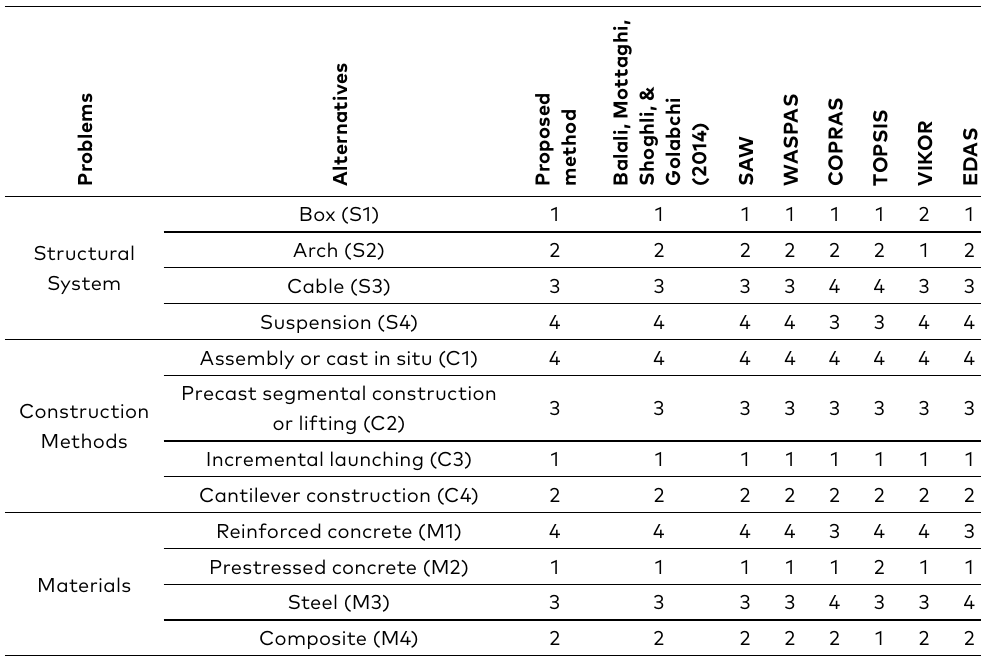
Table 10. The results of the comparative